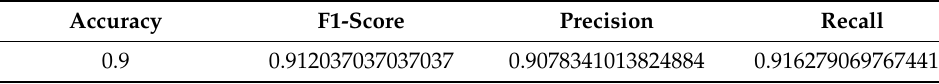
Table 6. The classification report for ten music genres.